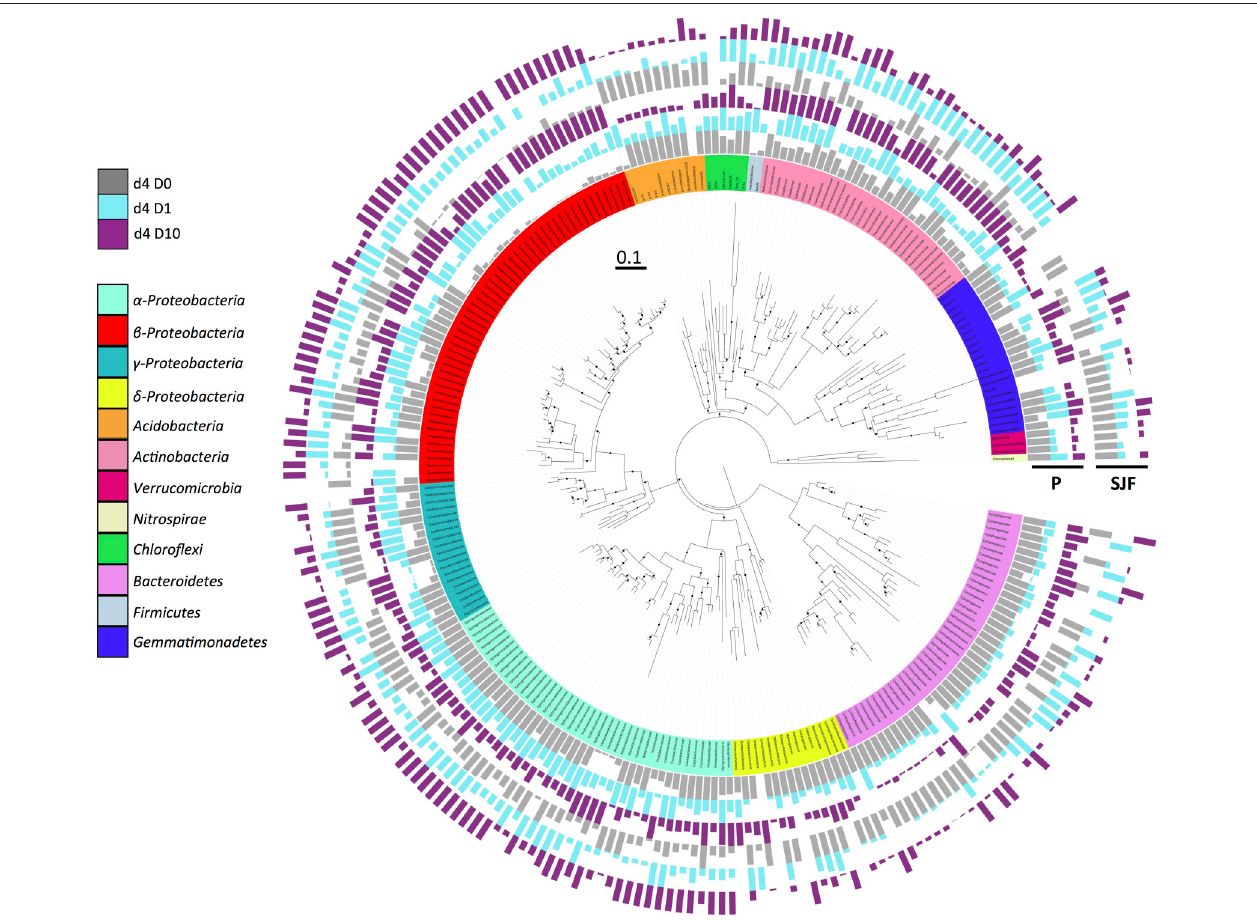
FIGURE 3 | Phylogenetic relationships and distribution of 16S rRNA OTUs observed in P and SJF soils at 4 days (d4). The maximum likelihood phylogeny consists of representative nucleotide sequences for OTUs. Node confidence ( n = 1000 bootstrap replicates) between 80 and 100% is shown by black dot. The affiliation of the represented OTUs to the main microbial groups (at phylum or class level) is indicated by different colors on the internal ring. Relative abundances of each OTU represented by bar plots are expressed as a proportion of the maximum abundance detected in each treatment, and indicated for P and SJF soils as follows (from inside to outside of the circle): gray, cyan, and dark violet for D0, D1, and D10,